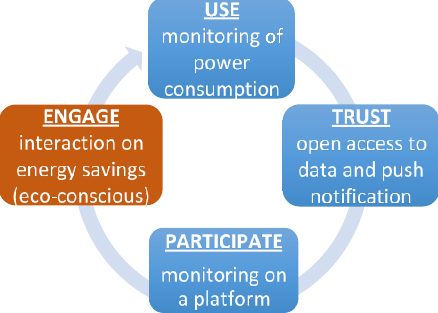
Figure 5. Smart invoices use case life cycle.